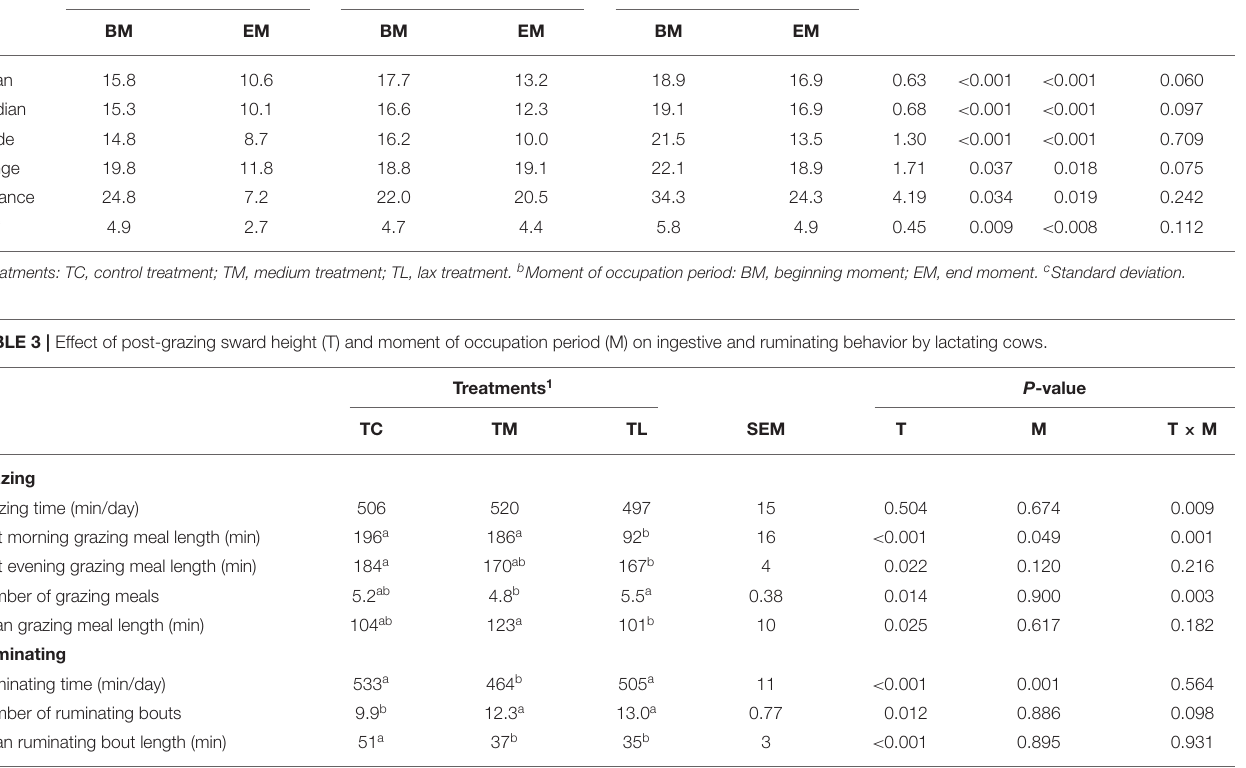
feeding stations and displacement rates were not affected by treatment, the moment of the occupation period, or time of the day. The number of steps between feeding stations at morning grazing was higher on TC (0.36 ± 0.06) than on TL (0.21 ± 0.04). The cows grazing on TC, at the beginning of the occupation period, had more steps between feeding stations (0.44 ± 0.09 vs. 0.21 ± 0.04) and per minute (1.86 ± 0.39 vs. 0.91 ± 0.20) at morning grazing than in the